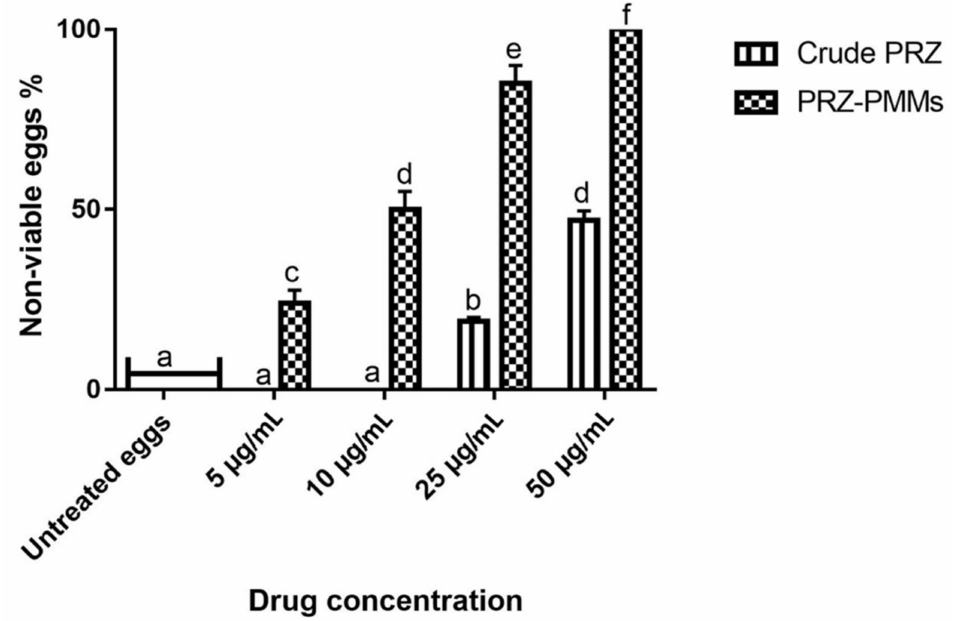
Figure 7. Non-viable eggs percentages in crude PRZ- and PRZ-PMMs-treated groups at different concentrations. Different letters on bars revealed a statistical difference at p <